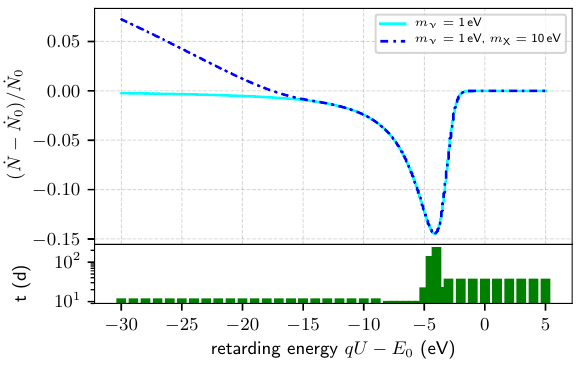
Figure 6 . Relative change of the integrated spectrum. Shown is the neutrino mass sensitive region by comparing a spectrum with neutrino mass m = 1 eV to a spectrum without neutrino mass (cid:23) (solid cyan). The peak of the measuring time distribution (green bars) sits right in the region where the neutrino mass causes the largest distortion to the spectrum. Furthermore the signal of a light boson type A with g (cid:23)J = 5 , m X = 10 eV is shown for comparison (dash dotted